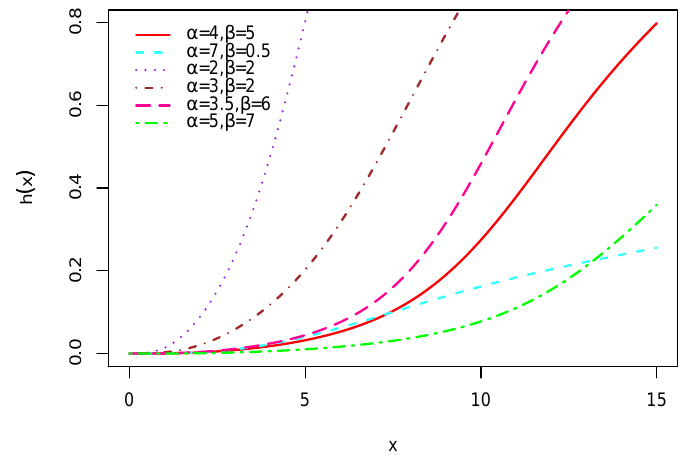
Figure 2. Curves of the hrf of the MOLBM distribution for different values of the